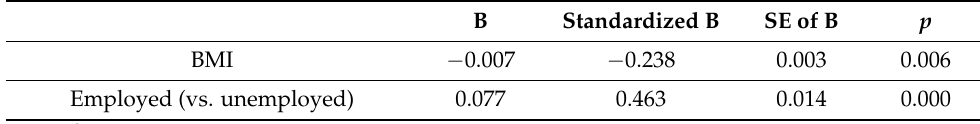
Table 8. Adjusted effects on Percentage of SB time in the final model.